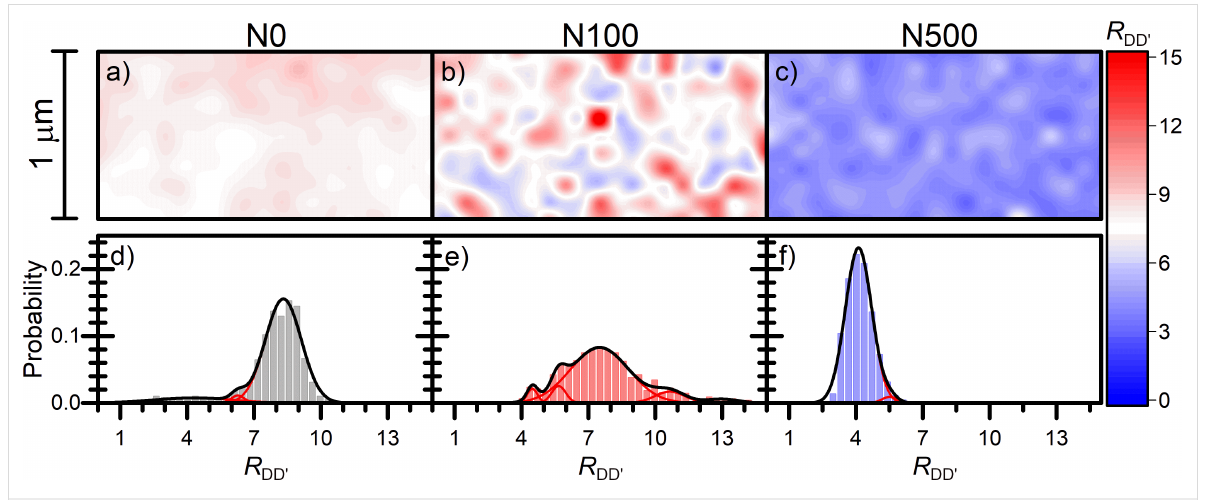
Figure 7: 2D maps (a–c) and histograms (d–f) of the intensity ratio between D and D’ bands ( R DD’ ) for all the three samples analysed.